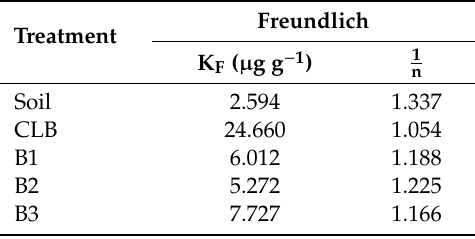
Table 13. Freundlich adsorption capacity (K F ) and Freundlich adsorption isotherm constant related to adsorption condition (1 / n) for nitrogen adsorption of di ff erent treatments.